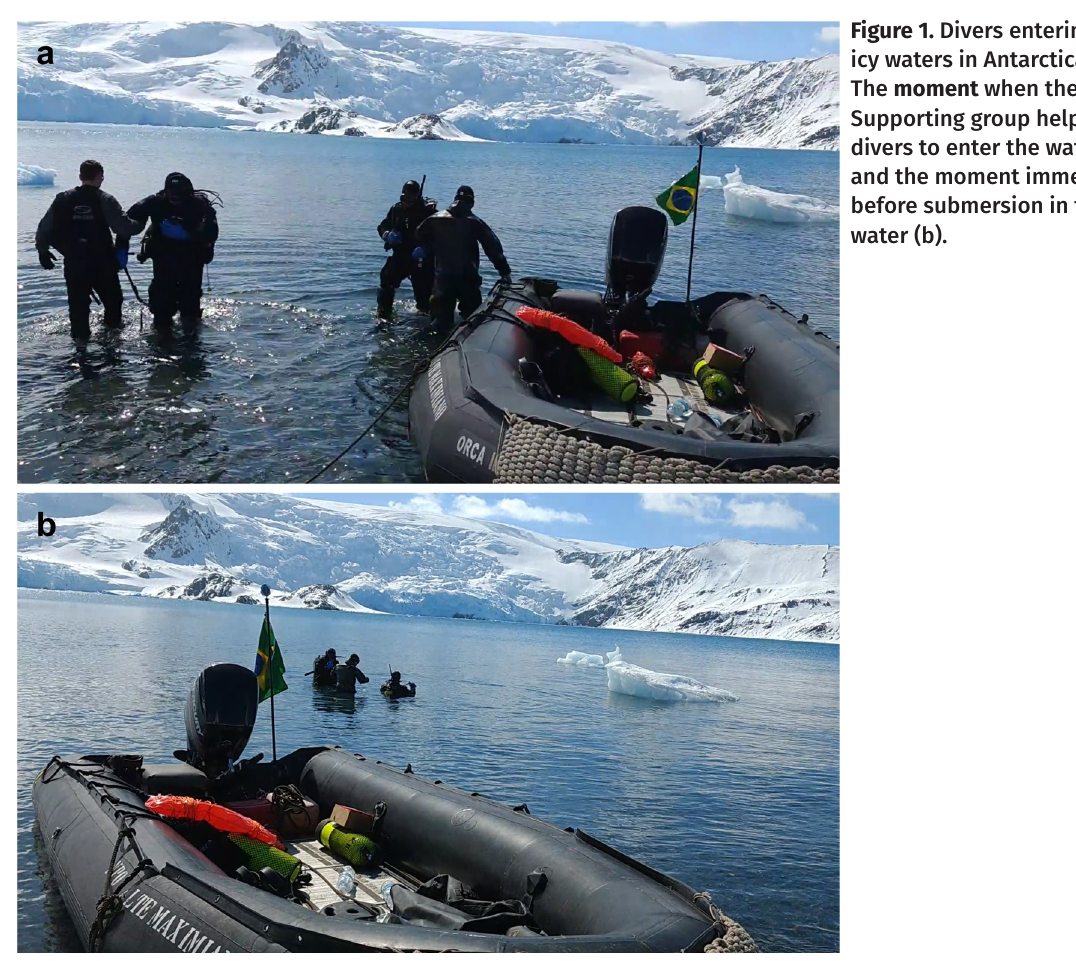
Figure 1. Divers entering the icy waters in Antarctica. The moment when the Supporting group helped the divers to enter the water (a), and the moment immediately before submersion in the water